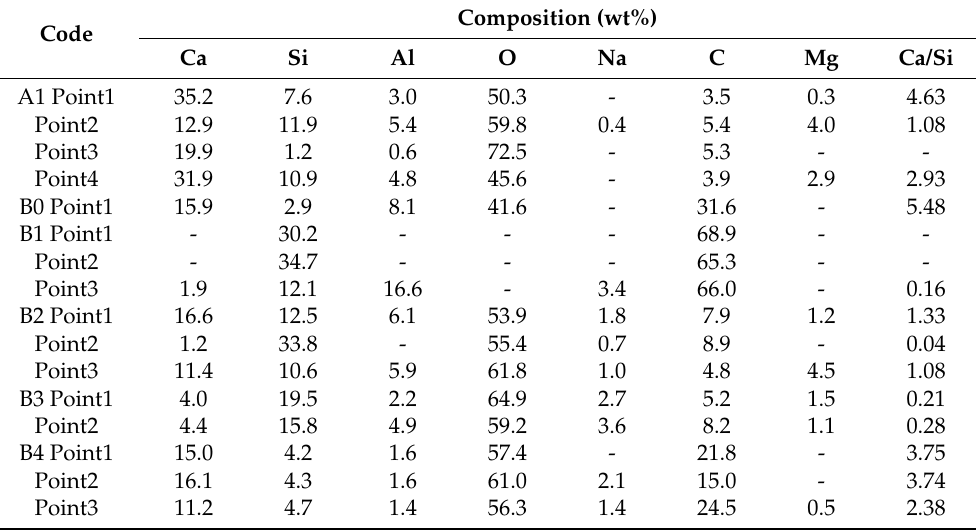
Table 3. EDS results of the samples at 28 days, atom